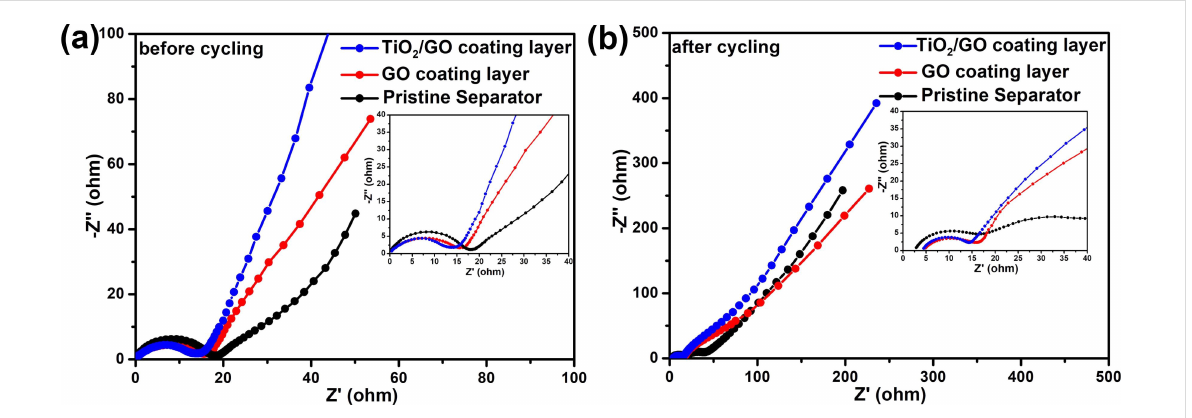
Figure 8: Nyquist plots of the Li/S batteries with pristine, GO-coated and TiO 2 /GO-coated separators (a) before cycling and (b) after cycling.